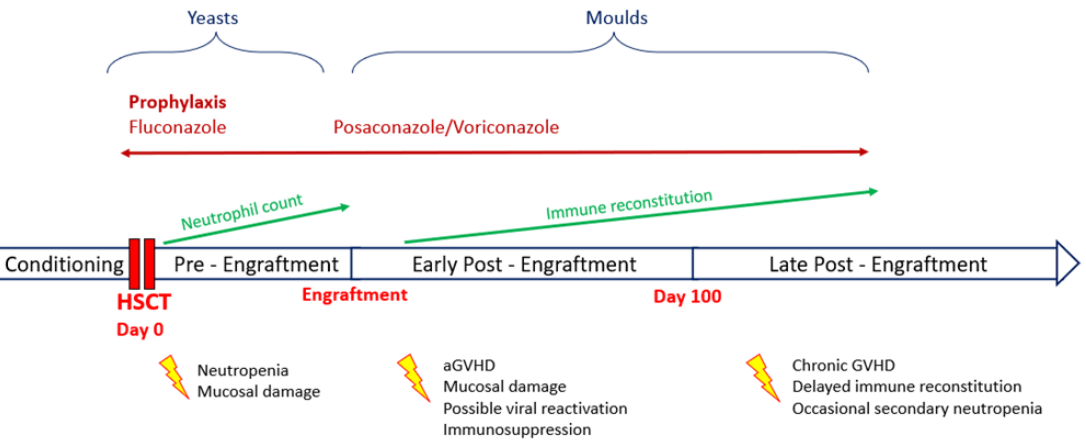
Figure 1. Timing, risk factors, epidemiology and prophylaxis indications for invasive fungal disease (IFD) in the context of hematopoietic stem cell transplantation (HSCT).